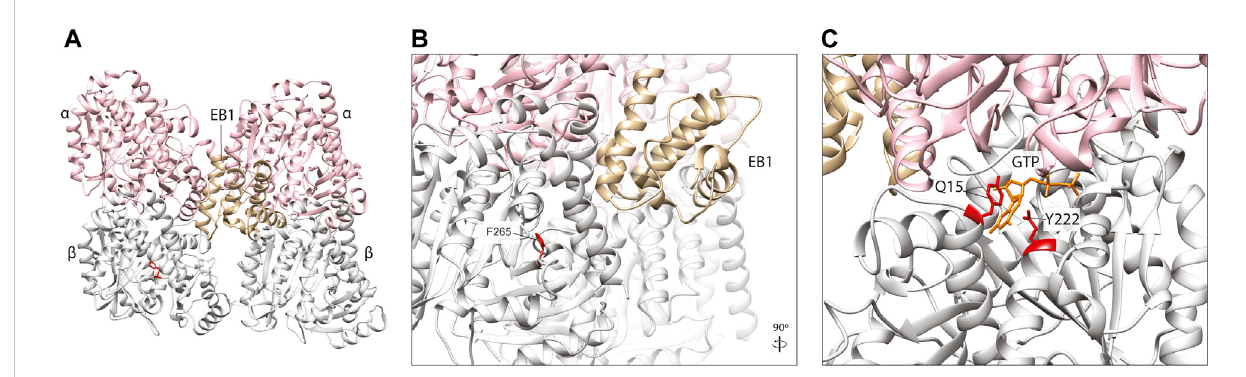
FIGURE 6 (A) In silico homology model of a microtubule proto fi lament with bound Calponin Homology domain of S. pombe EB1 homologue, Mal3 (labelled EB1). α -tubulins are represented by a pink ribbon, β -tubulins in silver and EB1 in gold (PDB 4ABO) (Maurer et al., 2012). (B) A detailed view of the EB1- tubulin interface. The F265 residue (red), associated with neurodevelopmental disease and shown to affect EB1 binding in yeast (Jaglin et al., 2009; Denarier et al., 2019), is not predicted to interact directly with this plus-end MAP, suggesting it may act via allosteric recon fi guration. (C) . TUBB5 Q15 and Y222 (red) are located within the β -tubulin GTP (orange)-binding site and variants affecting these residues might to affect nucleotide interaction and/or hydrolysis which, in turn, could in fl uence EB2